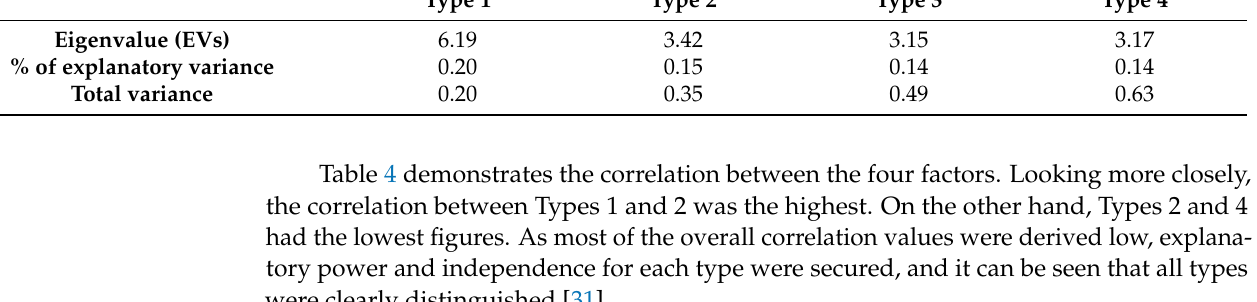
Table 3. Eigenvalue (EVs) and variance between types.